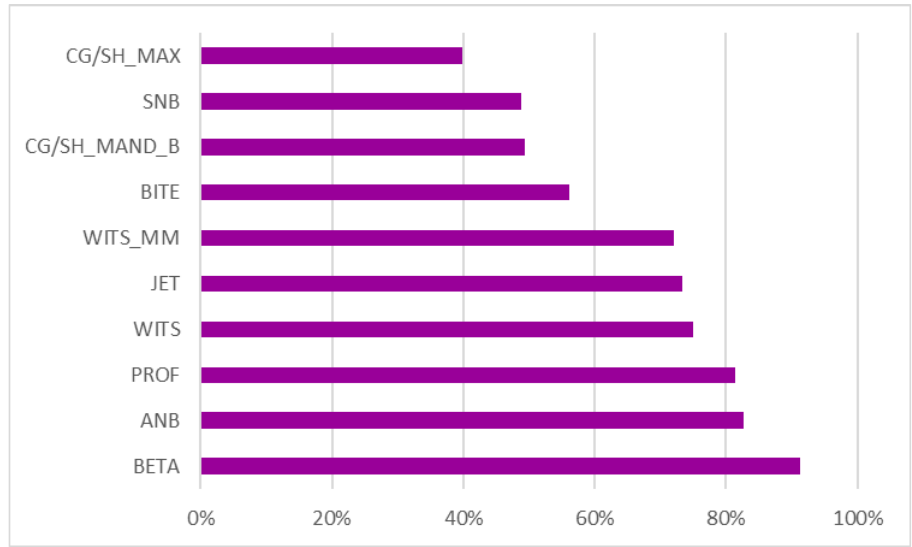
Figure 11. The ten parameters contributing the highest in determining the treatment planning of a case.